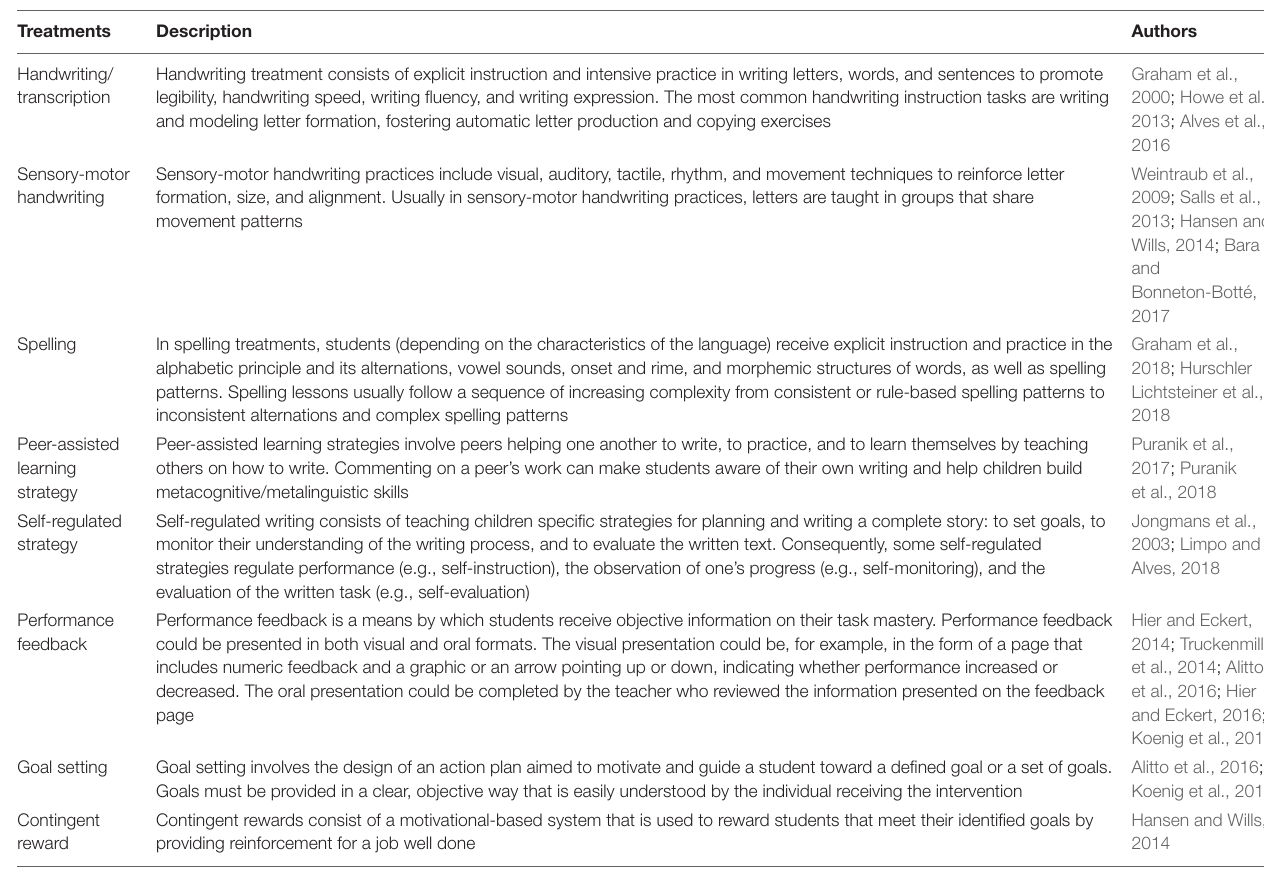
TABLE 2 | Identification of writing fluency